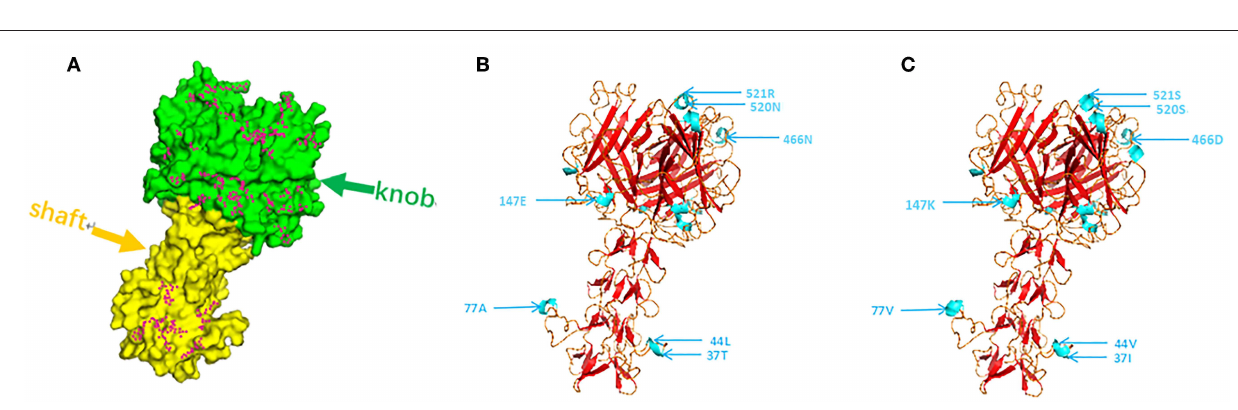
FIGURE 4 | (A) Using the fiber protein sequence of the CAdV-2 reference strain, the purple dot was identified as the mutation site of the fiber protein in the 19 strains tested in this study. (B,C) Tertiary structure of the Fiber protein of CC0710 strain and synthesis CC0710 strain harbored the major mutations. Altered antigenic epitopes are indicated in